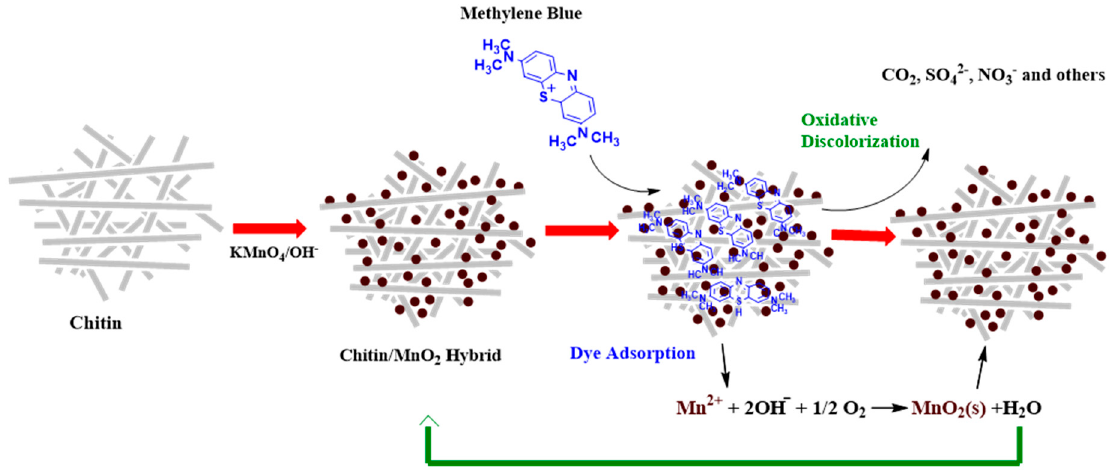
Table 5. Comparison of dye degradation efficiencies of the biopolymer-based AOP processes. Catalyst (s) Dye(s)